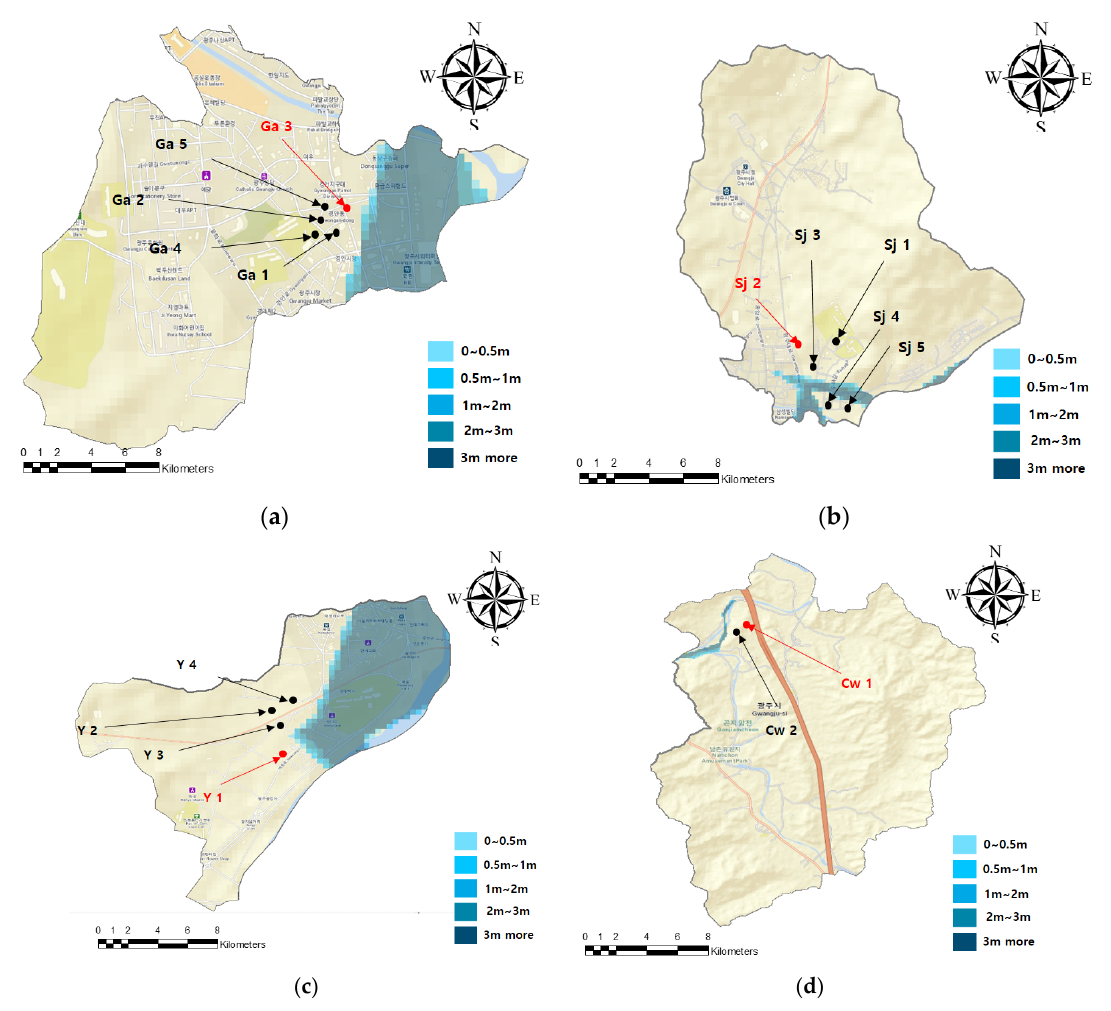
Figure 10. Optimal shelter map by administrative district in the event of a mega flood: ( a ) Gyeongan- dong; ( b ) Songjeong-dong; ( c ) Yeok-dong; ( d ) Chowol-eup; red dots are the priority shelters; black dots are the alternatives.